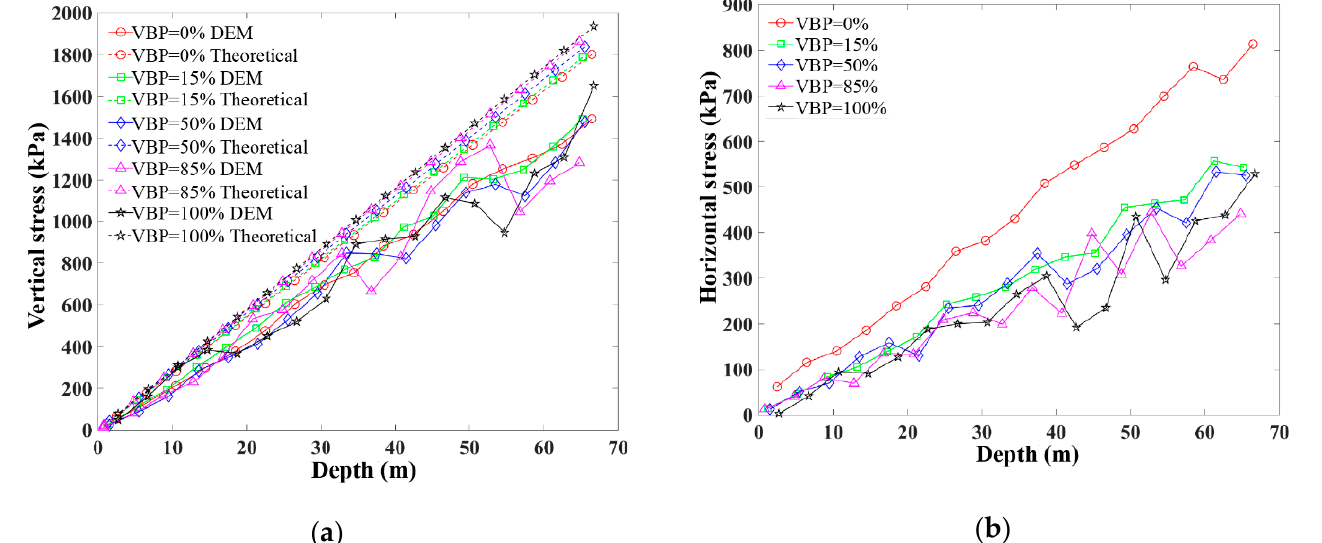
Figure 5. The stress distribution along the measuring line before tunnel excavation in the talus-like rock mass with different VBPs: ( a ) vertical stress and ( b ) horizontal